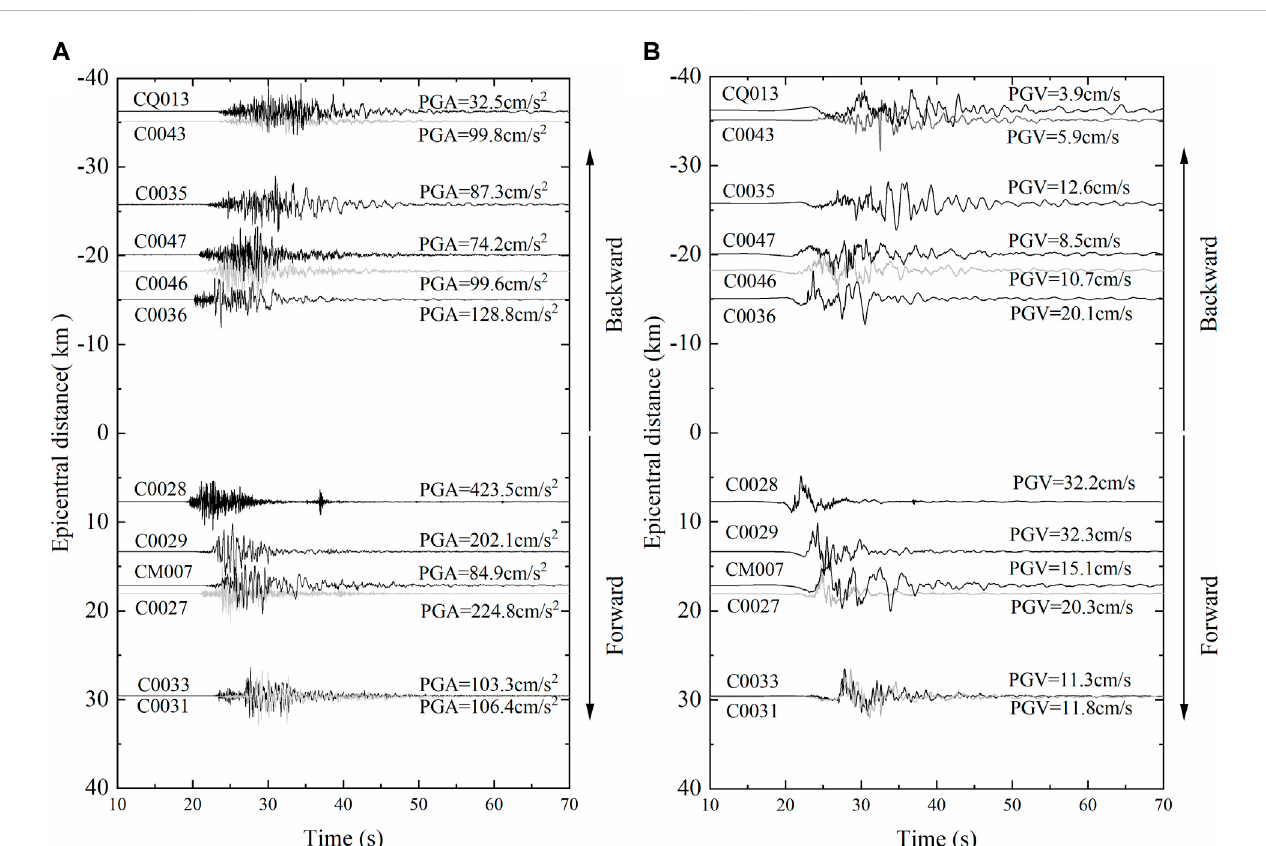
FIGURE 3 Comparison of (A) acceleration and (B) velocity EW component waveforms observed in the forward (southeast) and backward (northwest) regions.